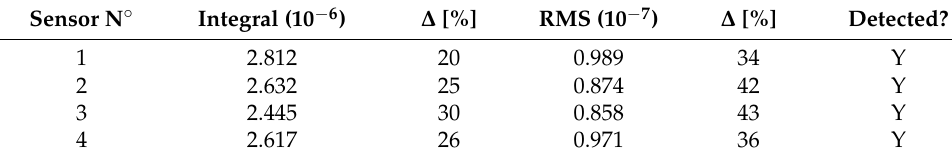
Figure 11. Scheme of void and IE device layout, edge below impactor. Detected Y—Yes, N—No, W—Warning.